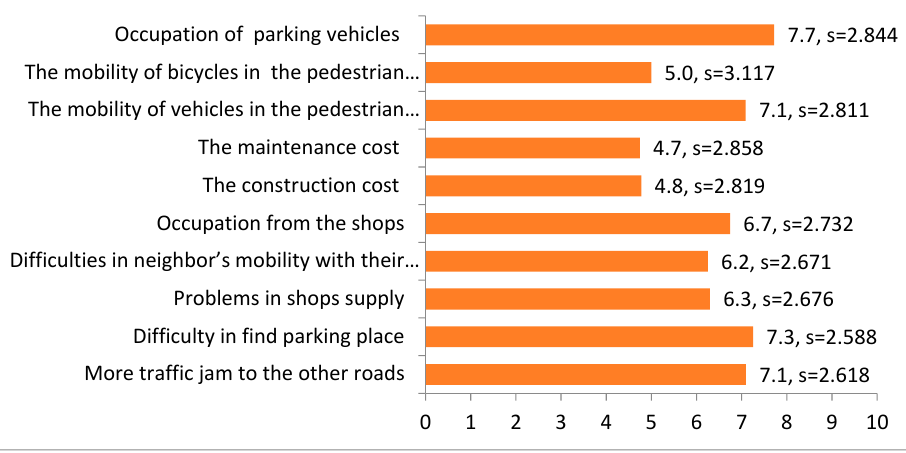
Figure 4. Evaluation of the disadvantages of pedestrian streets using a 10-point Likert scale (mean and standard deviations).